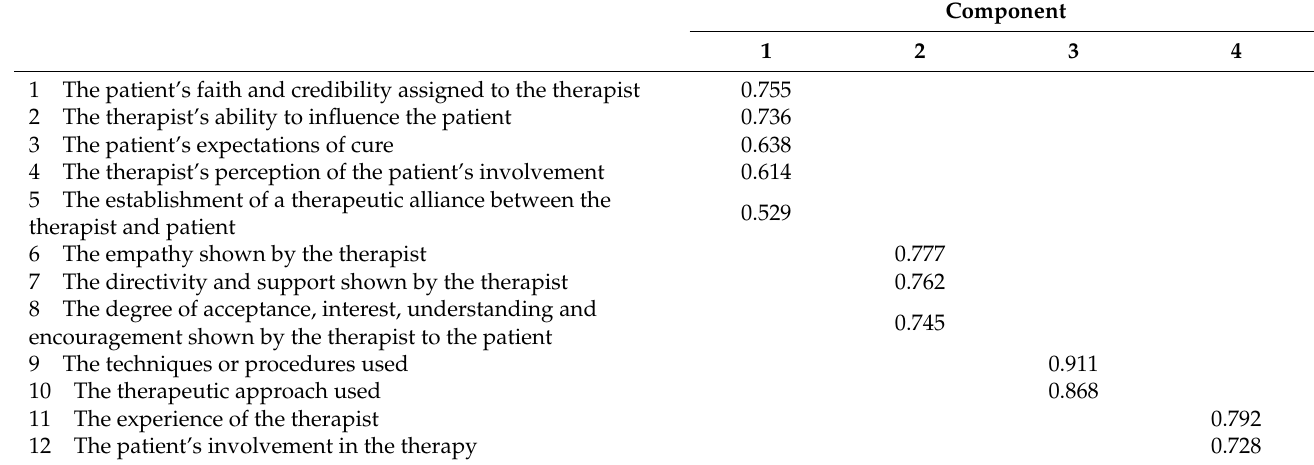
Figure 2. The four-factor model diagram with standardised estimates.